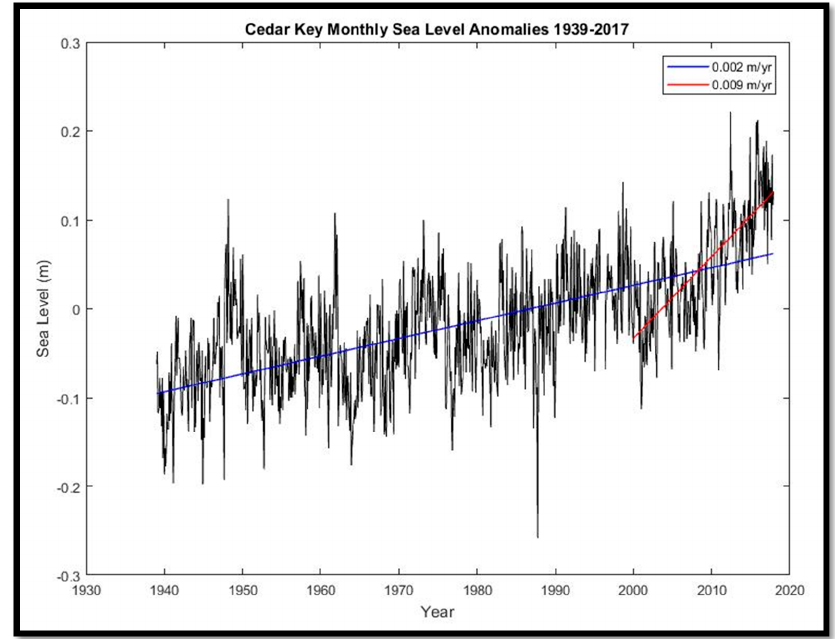
Figure 9. Monthly mean sea-level anomalies for Cedar Key, Florida (1939–2017). Trendlines are shown for the entire record (2 mm yr − 1 ) and for the period 2000–2017 (9 mm yr − 1 ).